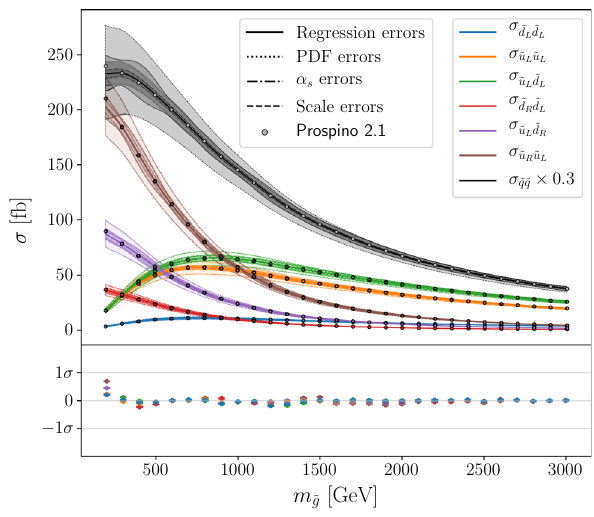
Fig. 15 First and second-generation squark–squark pair-production cross-section as a function of the average first and second-generation squark mass (left) and gluino mass (right), for a selection of final states